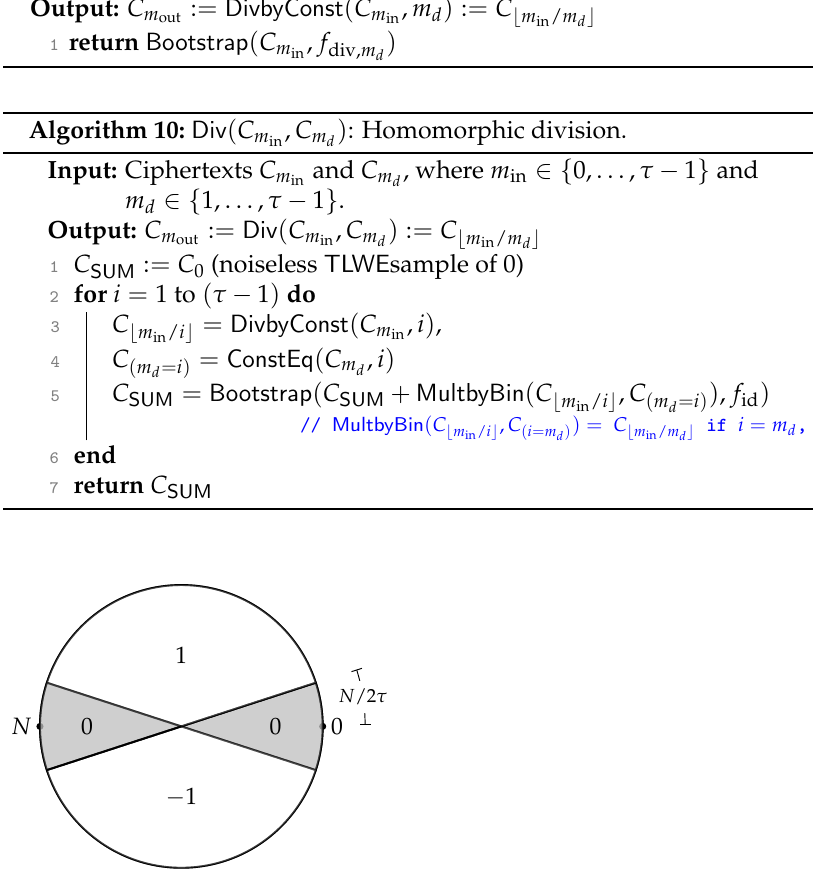
, m d ) : Homomorphic division by a constant in